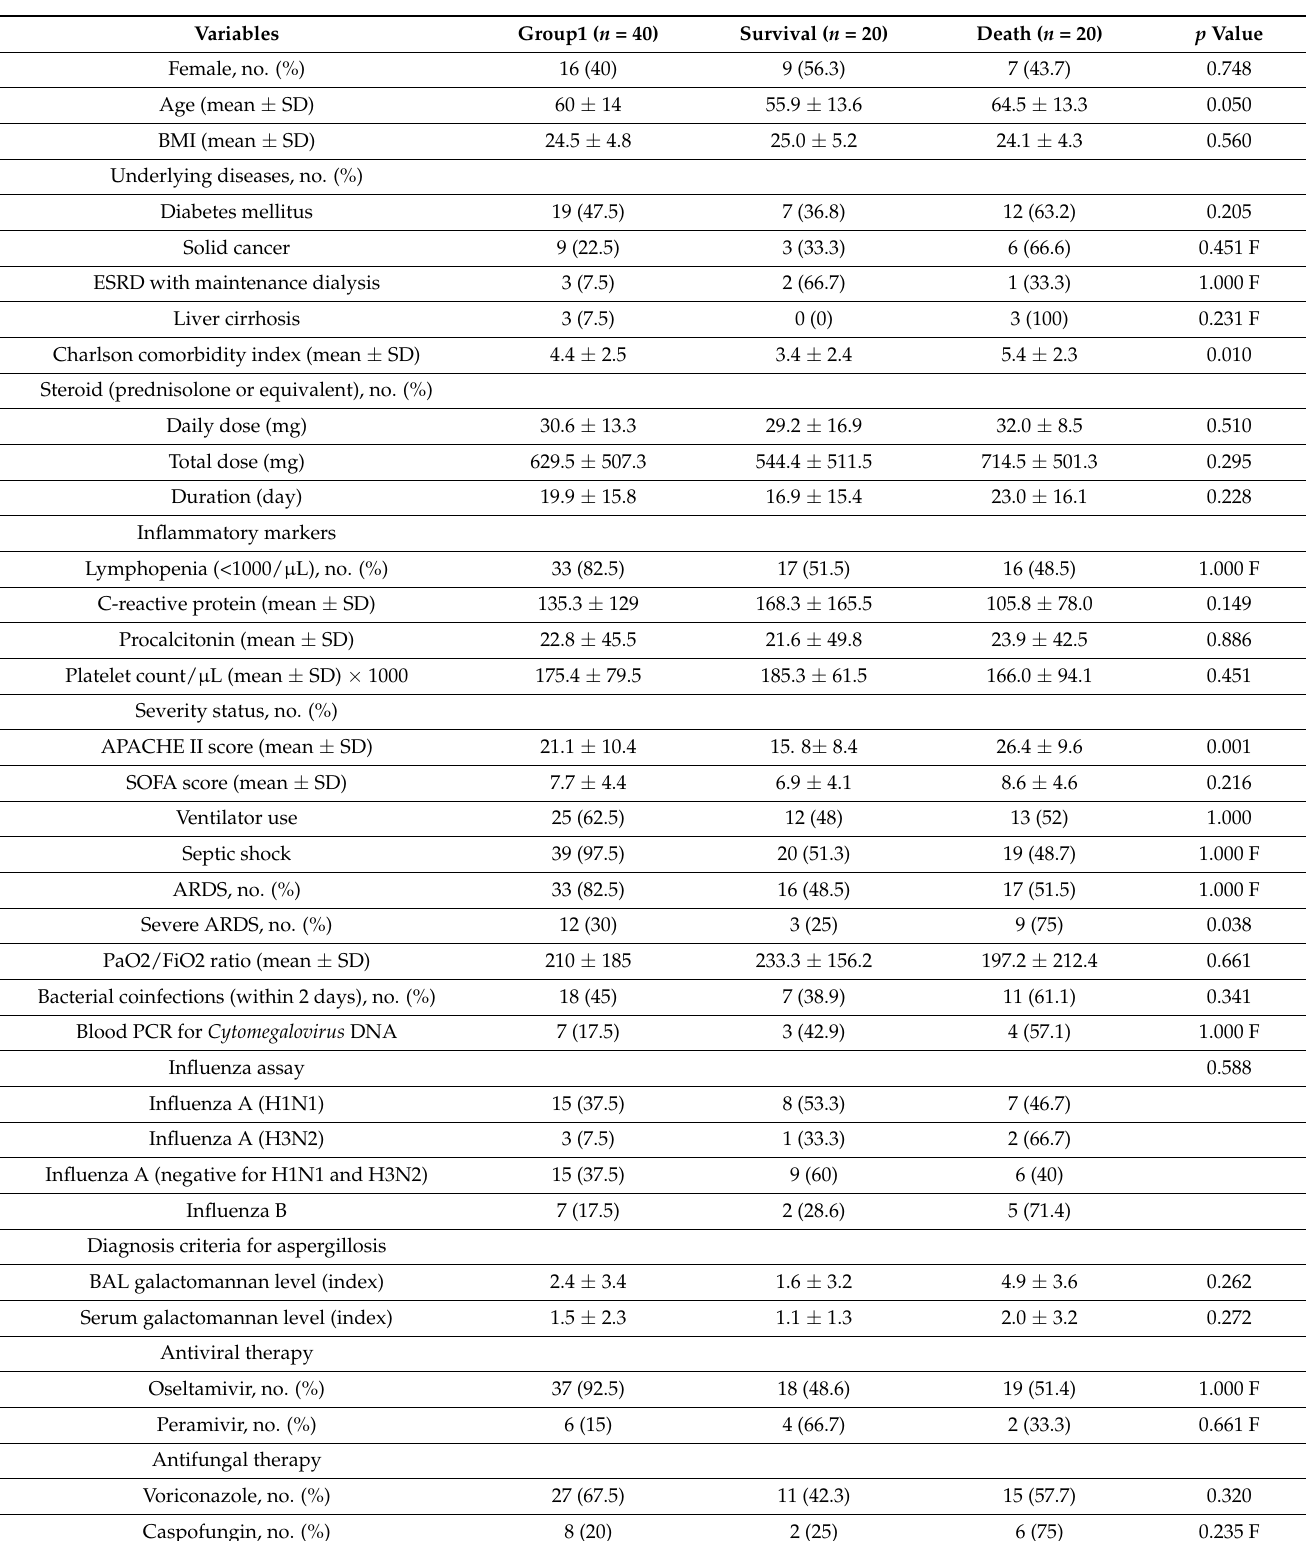
Table 3. Risk factors for mortality in ICU patients with coinfection of influenza and aspergillosis (group 1) using univari- ate